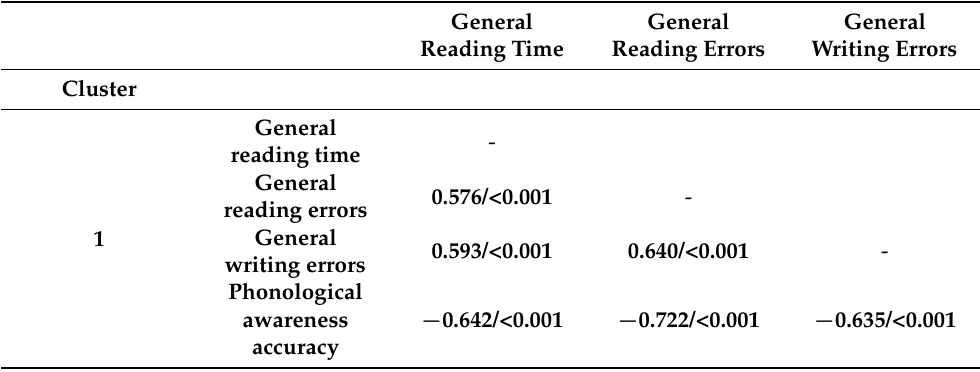
Table A2. Pearson’s partial correlations (controlling for age) of reading/writing/phonological processing measures and identification of the single cluster of inter-related variables ( n = 42). Reported values are Pearson’s correlation index r/ p -value. In bold, significant correlations.